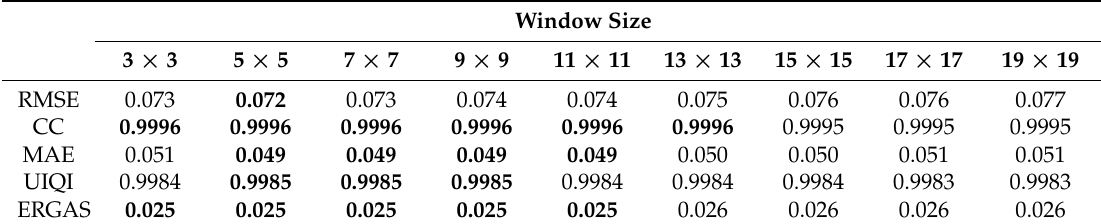
Table 1. Quantitative evaluation of the proposed method depending on different window size. The optimal values in terms of quality index are highlighted in bold.